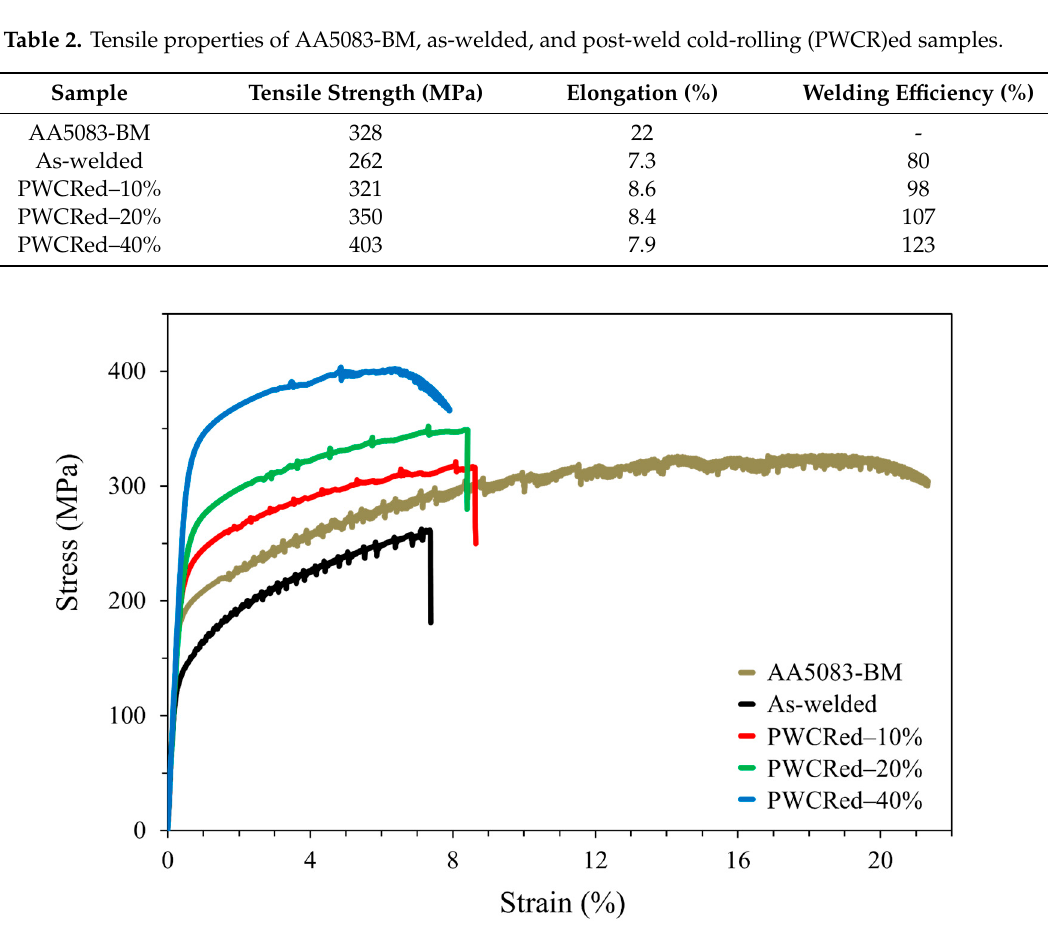
Figure 5. Stress–strain diagram of the AA5083-base metal (BM), as-welded, and PWCRed